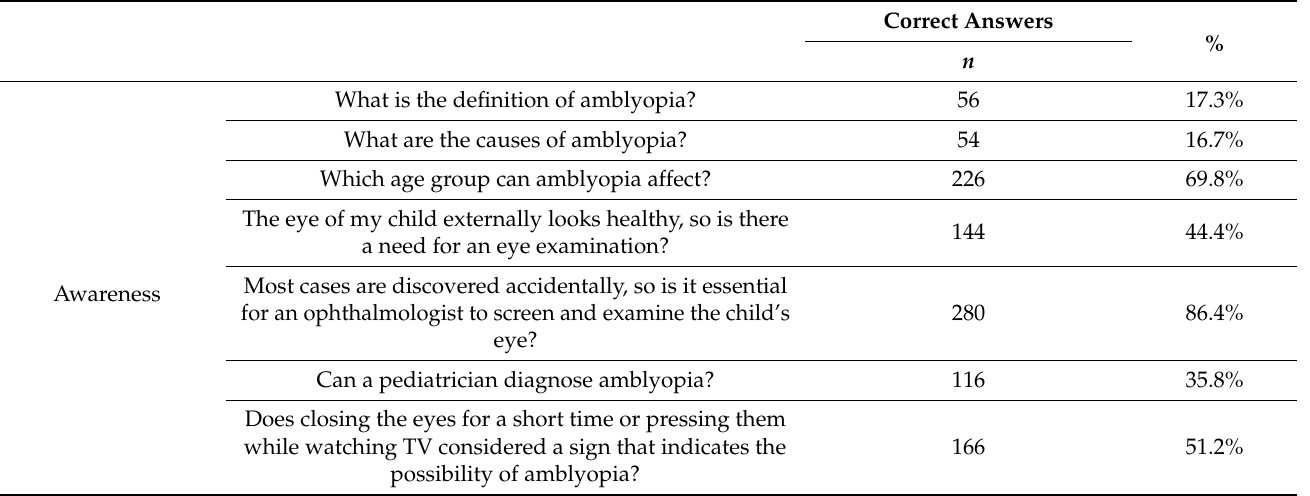
Table 2. Participants’ responses towards awareness of